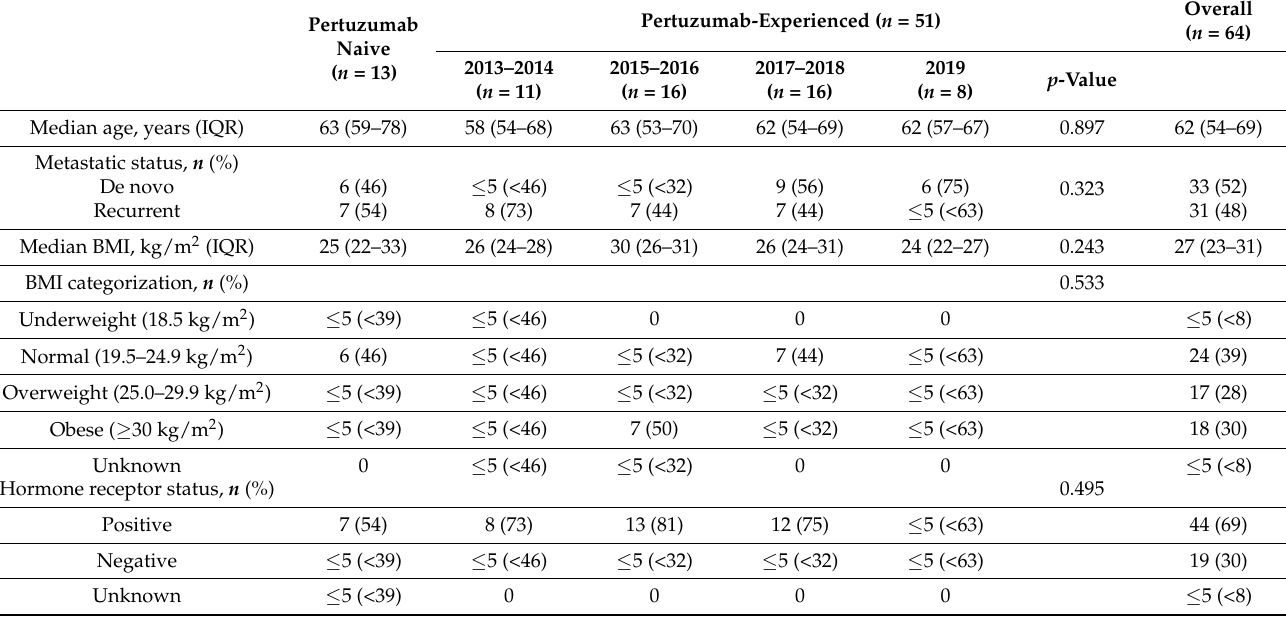
Table A4. Demographic and disease characteristics on the index date a in the lapatinib cohort b stratified by prior pertuzumab